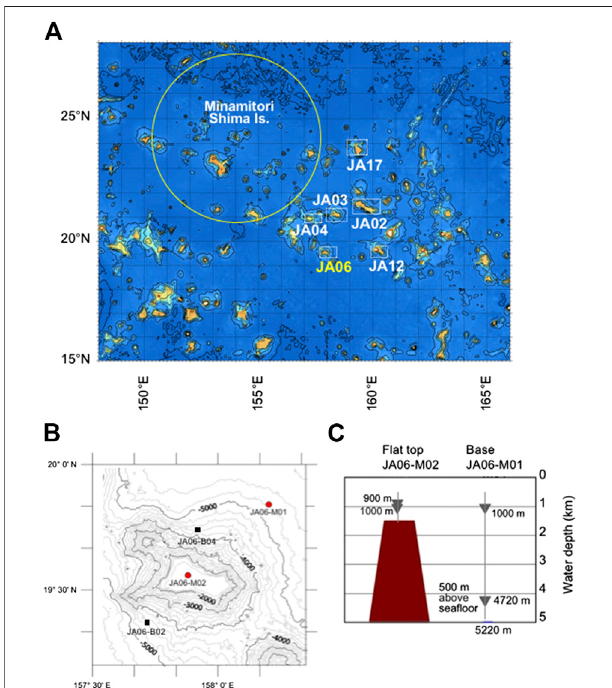
FIGURE 1 | (A) Map of Japan ’ s exploration area for cobalt-rich ferromanganese crusts, covering six seamounts (JA02, 03, 04, 06, 12, and 17) southeast of Minamitori Shima Island (also known as Marcus Island) in the northwest Paci fi c. Yellow circle indicates Japan ’ s exclusive economic zone (EEZ). (B) Bathymetry of JA06 Seamount showing locations of mooring sites JA06-M01 and M02 (red circles) and sampling sites for deep-sea sediments (pelagicclay) (blacksquares; JA06-B02and B04). (C) Deployment depths of sediment traps used in our